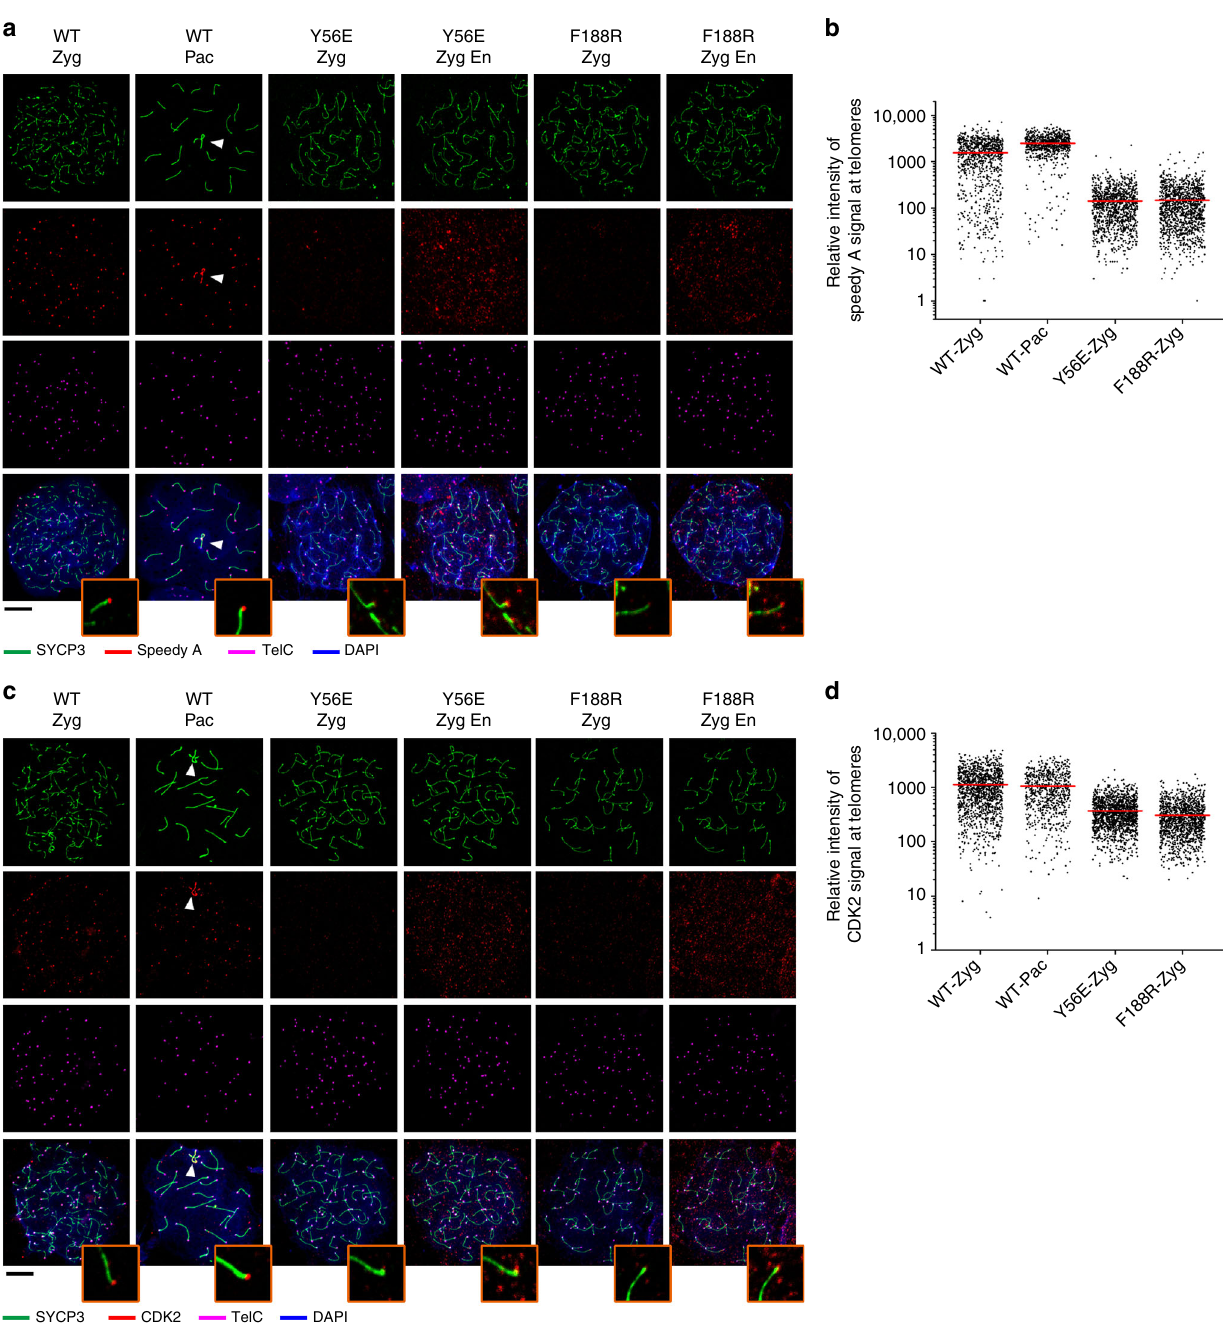
Fig. 9 Telomere localization of Speedy A and CDK2 is reduced in mutant nuclei. a Immuno fl uorescence – fl uorescence in situ hybridization (IF-FISH) images of chromosome spreads from adult spermatocytes of the indicated genotypes. Chromosome spreads were immunostained for SYCP3 (green) and Speedy A (red) and subjected to telomere FISH (TelC-FISH) (magenta). DNA was stained by 4,6-diamidino-2-phenylindole (DAPI; blue). Zyg Zygotene, Pac Pachytene, En showing enhanced signals (red) of Speedy A with a lower cutoff. White arrowheads indicate sex chromosomes. Scale bars, 10 μ m. b Quanti fi cation of the relative intensity of Speedy A foci at telomeres in wild-type (WT) or Terb2 -mutant spermatocytes in a . c IF-FISH images of chromosome spreads from adult spermatocytes of the indicated genotypes. Chromosome spreads were immunostained for SYCP3 (green) and CDK2 (red) and subjected to telomere FISH (TelC-FISH) (magenta). DNA was stained by DAPI (blue). Zyg Zygotene, Pac Pachytene, En showing enhanced signals (red) of CDK2 with a lower cutoff. White arrowheads indicate sex chromosomes. Scale bars, 10 μ m. d Quanti fi cation of the relative intensity of CDK2 foci at telomeres in WT or Terb2 -mutant spermatocytes in c . Source data are provided as a Source Data fi